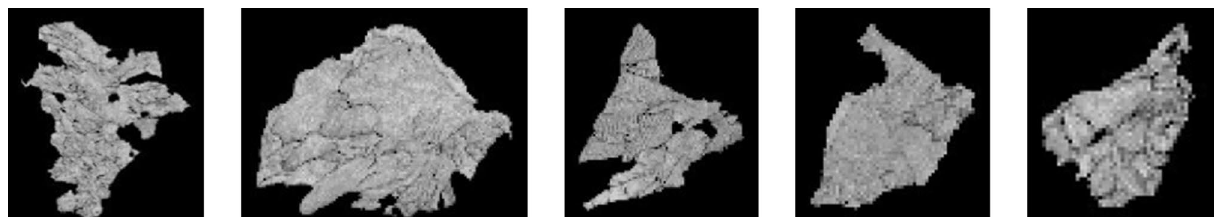
Figure 4. Examples of segmented EBSD images by grain (Steel D). Pixel size of the leftmost image is 90 by